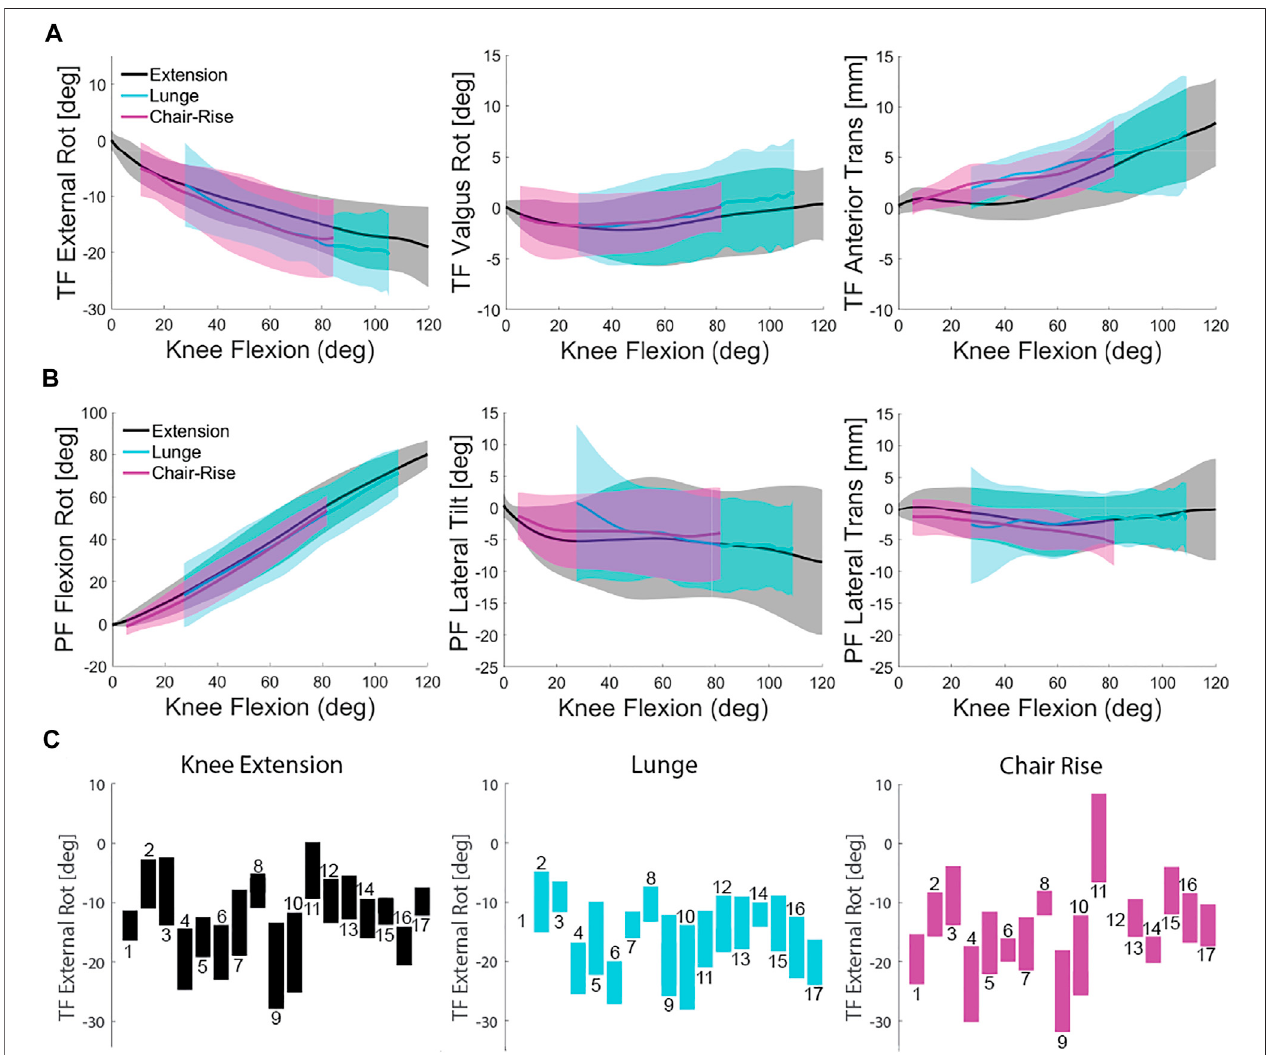
FIGURE 2 | (A) Comparison of tibia kinematics relative to the femur showing average and one standard deviation of the three activities. (B) Comparison of patella kinematics relative to the femur showing average and one standard deviation of the three activities. (C) TIE range of motion for each subject for all three activities (lunge was not performed by Subject